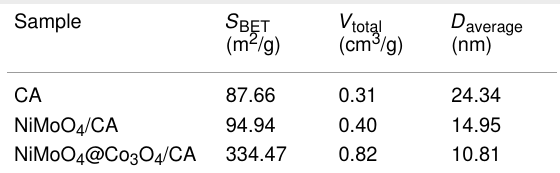
Table 1: Pore structure parameters of the